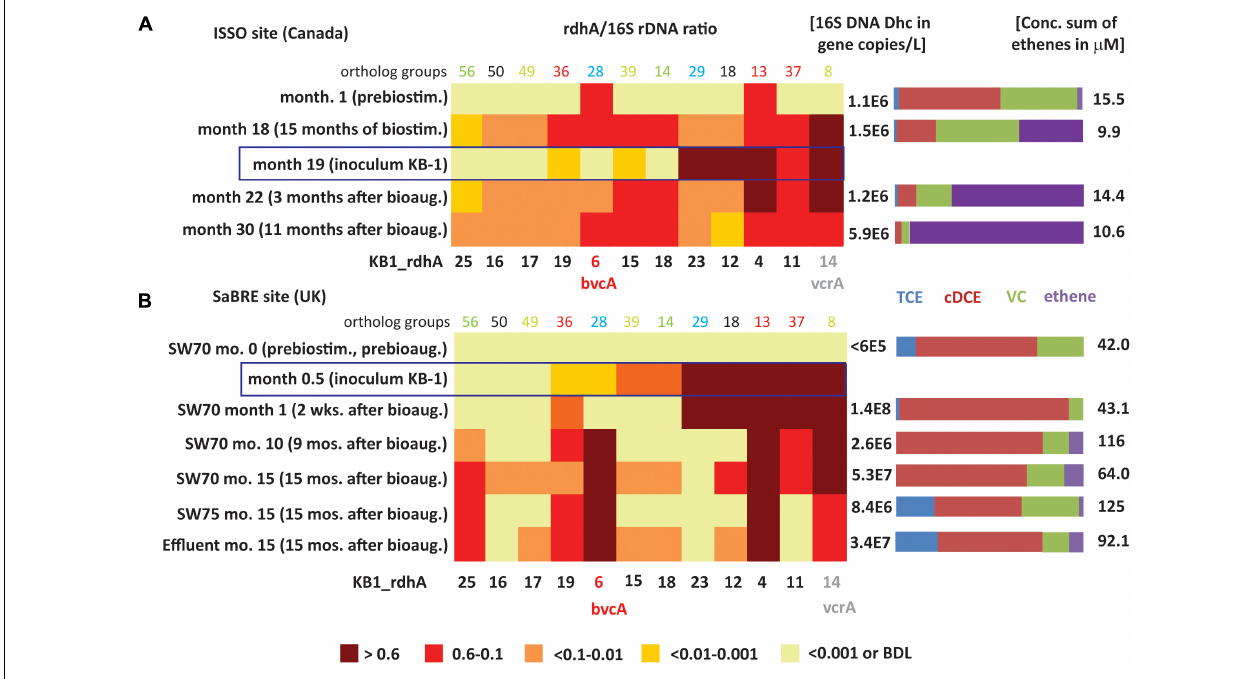
FIGURE 4 | Heatmaps showing D. mccartyi rdhA /16S rRNA gene copy ratios in field samples. (A) Canadian ISSO site. (B) United Kingdom SaBRE site. Corresponding absolute copies of D. mccartyi per L and concentrations of chlorinated ethenes are represented on the right side of each panel. Data from the ISSO site are from the composite pipeline (see Supplementary Figure S1). Data from the SaBRE site are from the influent (INF), sampling wells (SW70 and SW75) and effluent (EFF) of the test plot (see Supplementary Figure